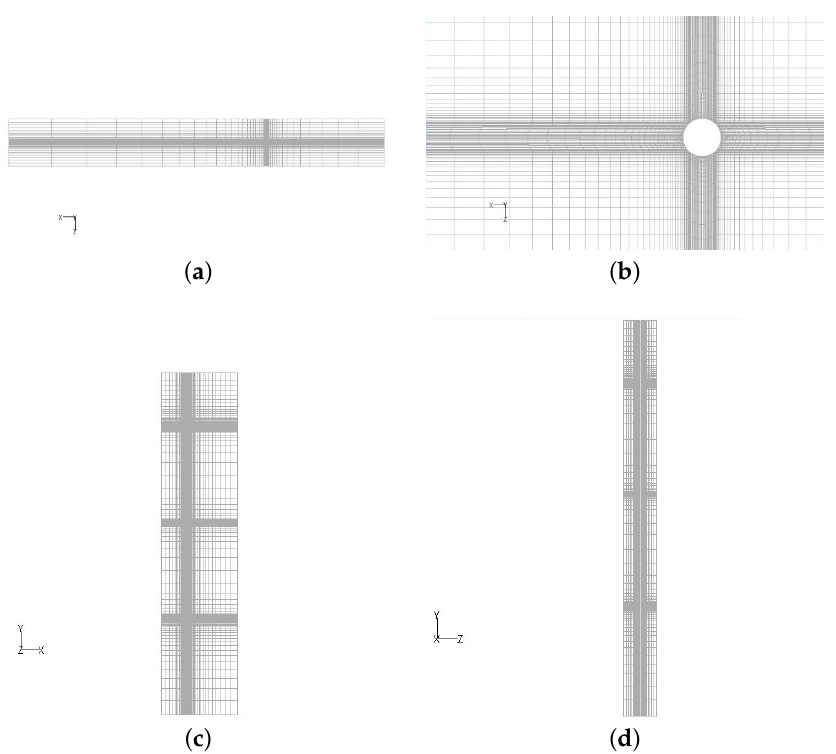
Figure 2. Schematic diagram of TTR calculation grid: ( a ) schematic diagram of the grid perpendicular to the depth direction (Y); ( b ) partial schematic diagram of the grid perpendicular to the depth direction (Y); ( c ) schematic diagram of the depth direction (Z) grid; ( d ) partial schematic diagram of the grid perpendicular to the inline flow direction